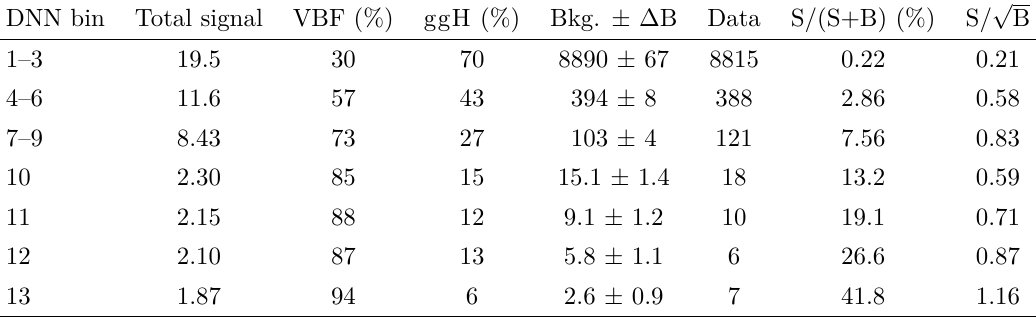
Table 2 . Event yields in each bin or in group of bins defined along the DNN output in the VBF-SR for various processes. The expected signal contribution for m = 125 . 38 GeV (S), produced via VBF H and ggH modes and assuming SM cross sections and B (H → µ + µ − ) , is shown. The background yields (B) and the corresponding uncertainties ( ∆B ) are obtained after performing a combined S+B fit across the VBF-SR and VBF-SB regions and each data-taking period. The observed event √ yields, S/(S+B) ratios and S / B ratios are also